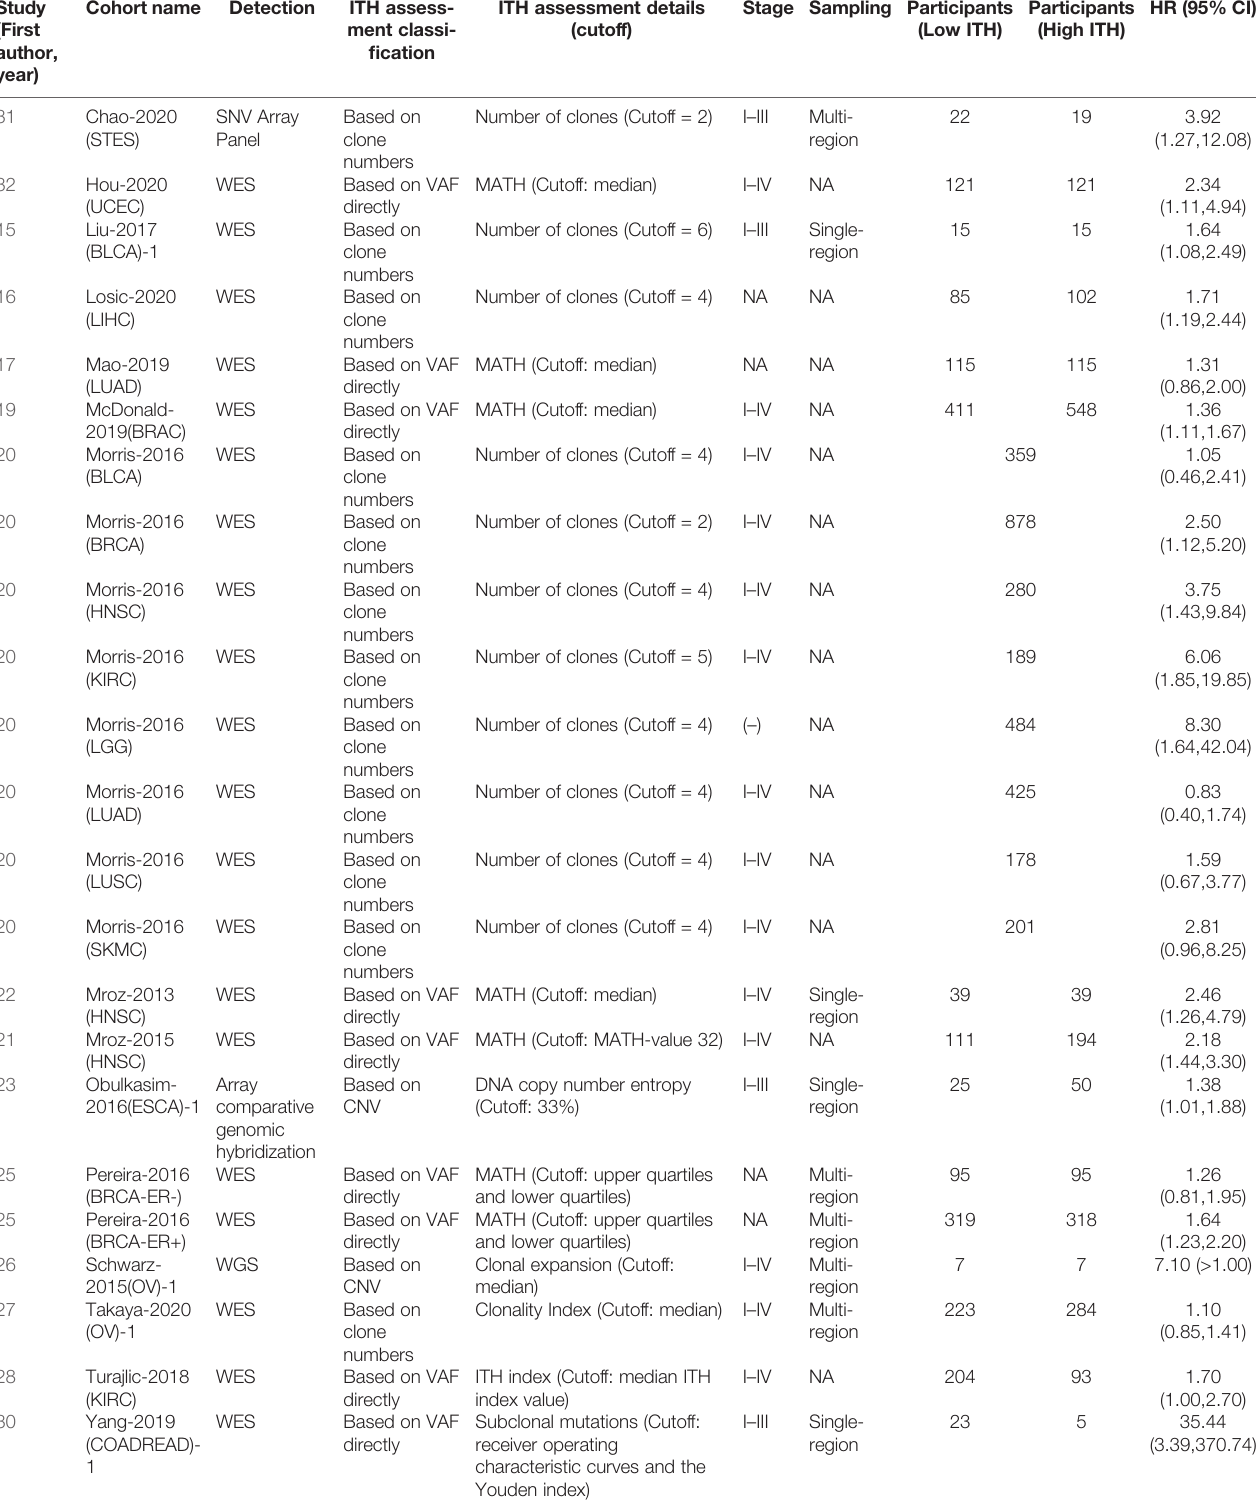
TABLE 1 | Characteristics of ITH Assessment